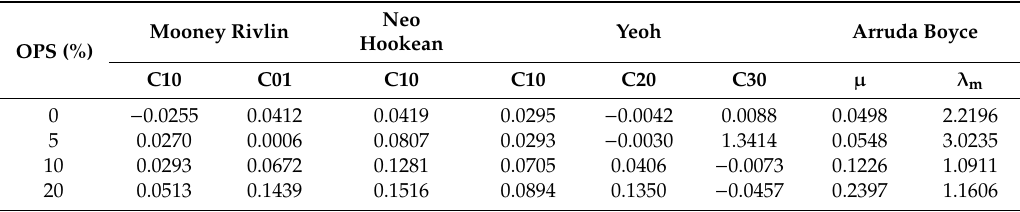
Figure 2. Typical response of circular shaped ROPS specimen to compressive loading: ( a ) variation of compressive stress with N; ( b ) effect of increasing OPS content on measured stress–strain response of compressive stress with N; ( b ) e ff ect of increasing OPS content on measured stress–strain response of ROPS samples in loading stage; ( c ) curve fitting of different SEFs with the experimental data. ROPS samples in loading stage; ( c ) curve fitting of di ff erent SEFs with the experimental data. Table 2. Material coefficients of stable strain energy functions of circular ROPS specimens. Table 2. Material coe ffi cients of stable strain energy functions of circular ROPS